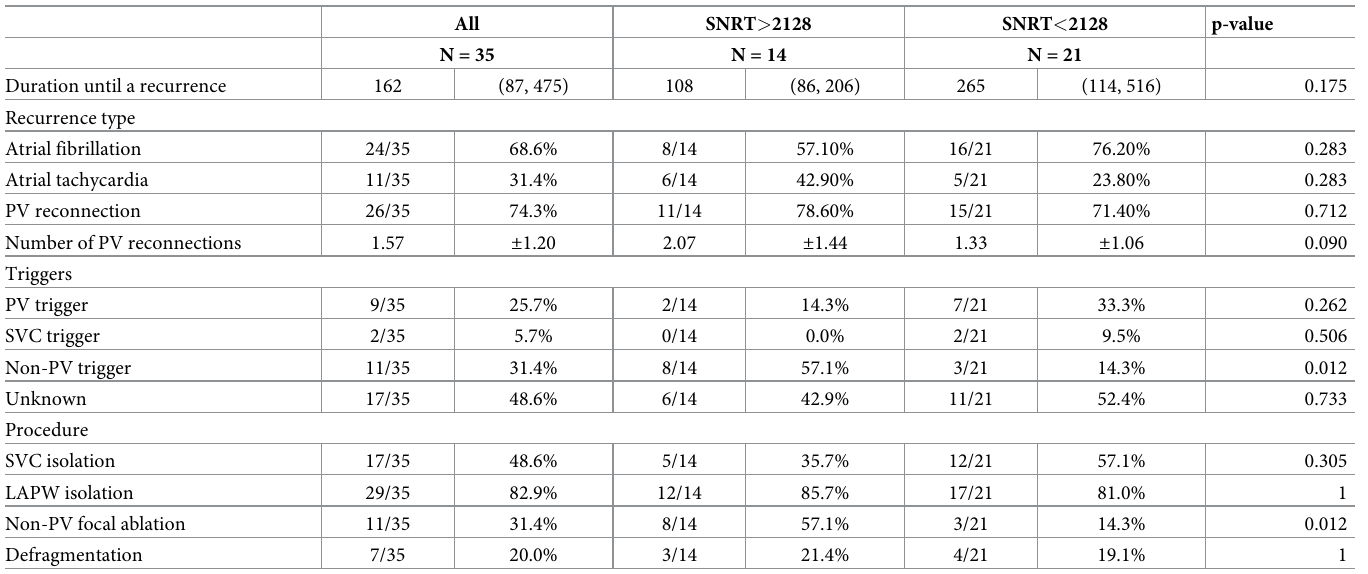
Table 3. Second ablation session.